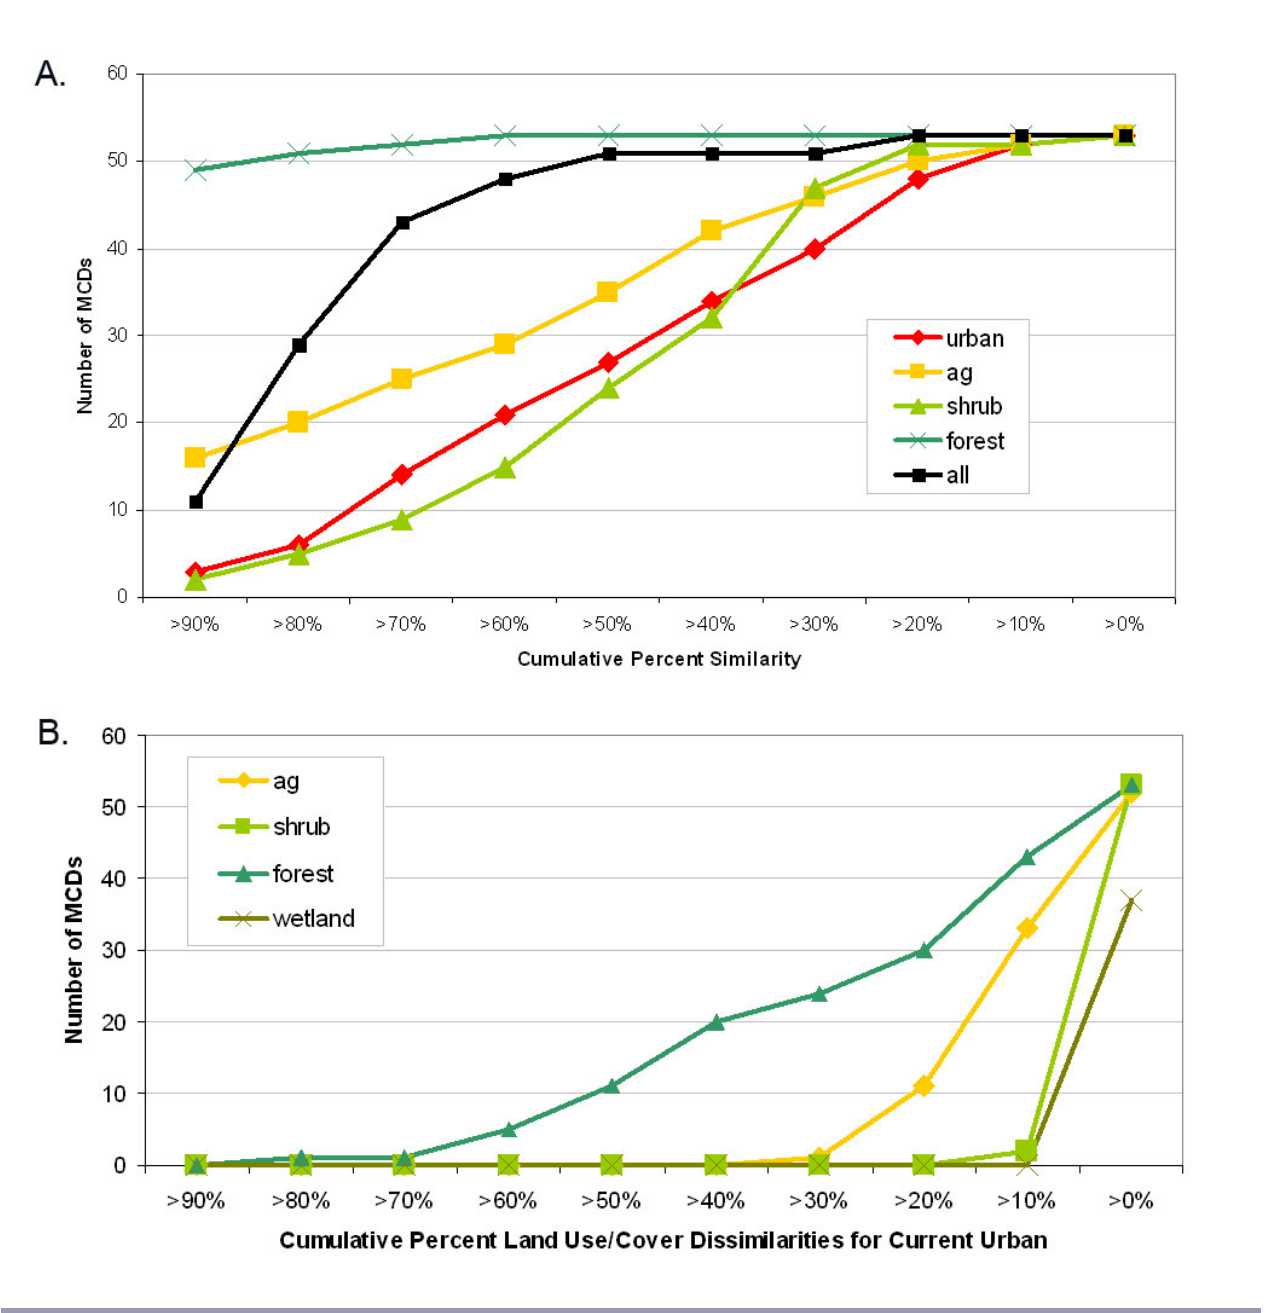
Fig. 9 . Cumulative percent similarities (A) and dissimilarities (B) for current urban land-use/cover